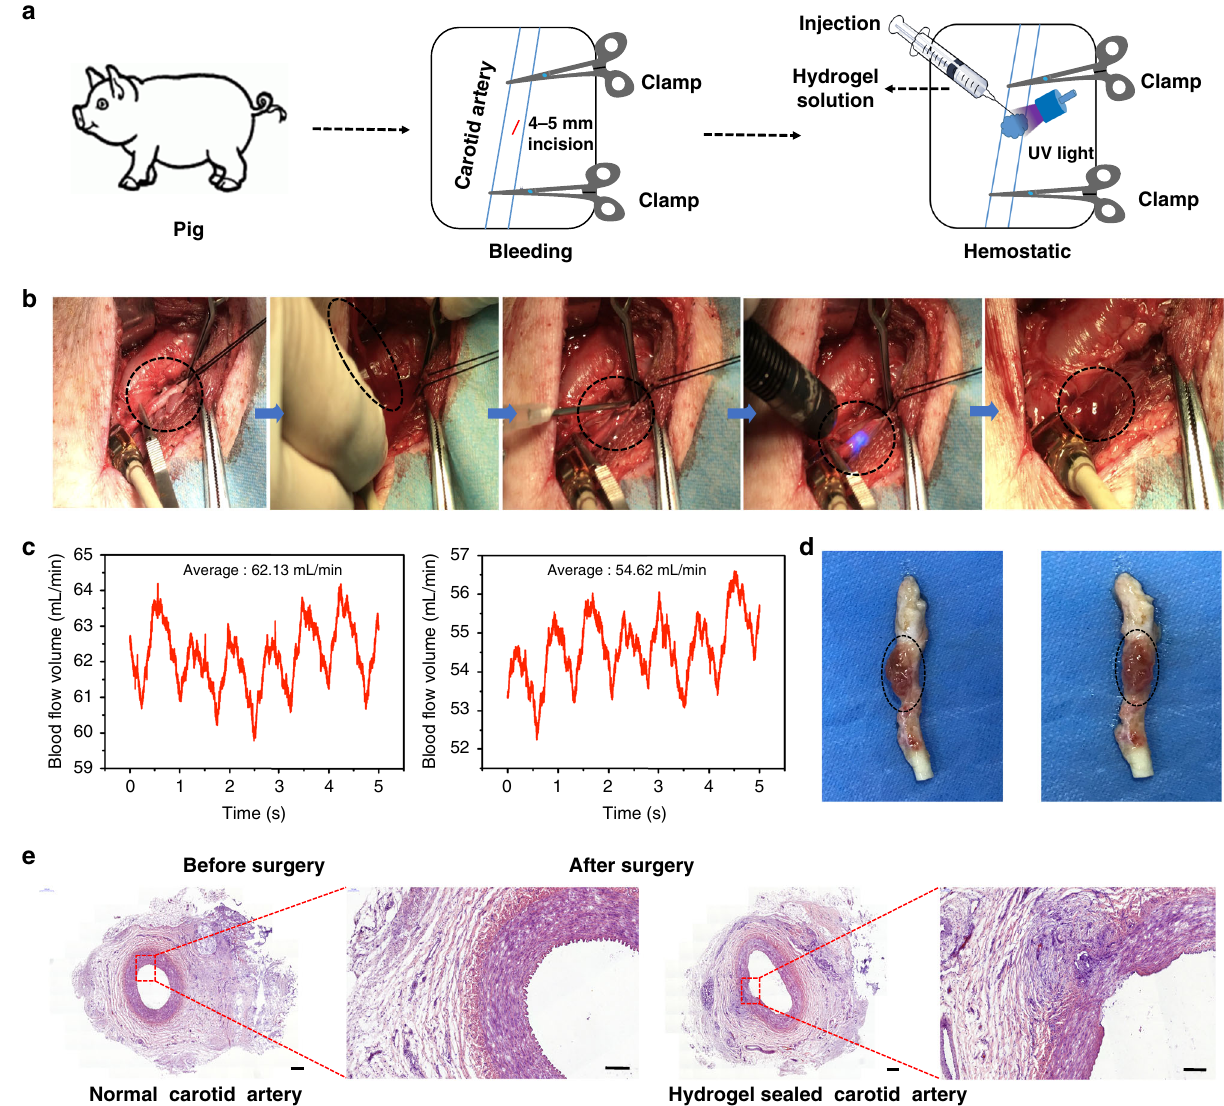
Fig. 3 Hemostatic properties of the matrix gel in a pig carotid artery damage model. a Schematic diagram of the surgical procedure. b Gross view of the rapid hemostasis and sealing in a pig carotid artery model. c The blood fl ow volumes through the pig ’ s carotid artery before and after surgery. d Macroscopic view of a healing hydrogel-covered carotid artery, 2 weeks after operating. e Postoperative tissue sections stained with hematoxylin – eosin, showing normal carotid artery (left) and the hydrogel-repaired vessels (right). Scale bar: 500 μ m (left plates); 200 μ m (right plates, enlarged) ( n = 3) Source data are available in the Source Data fi